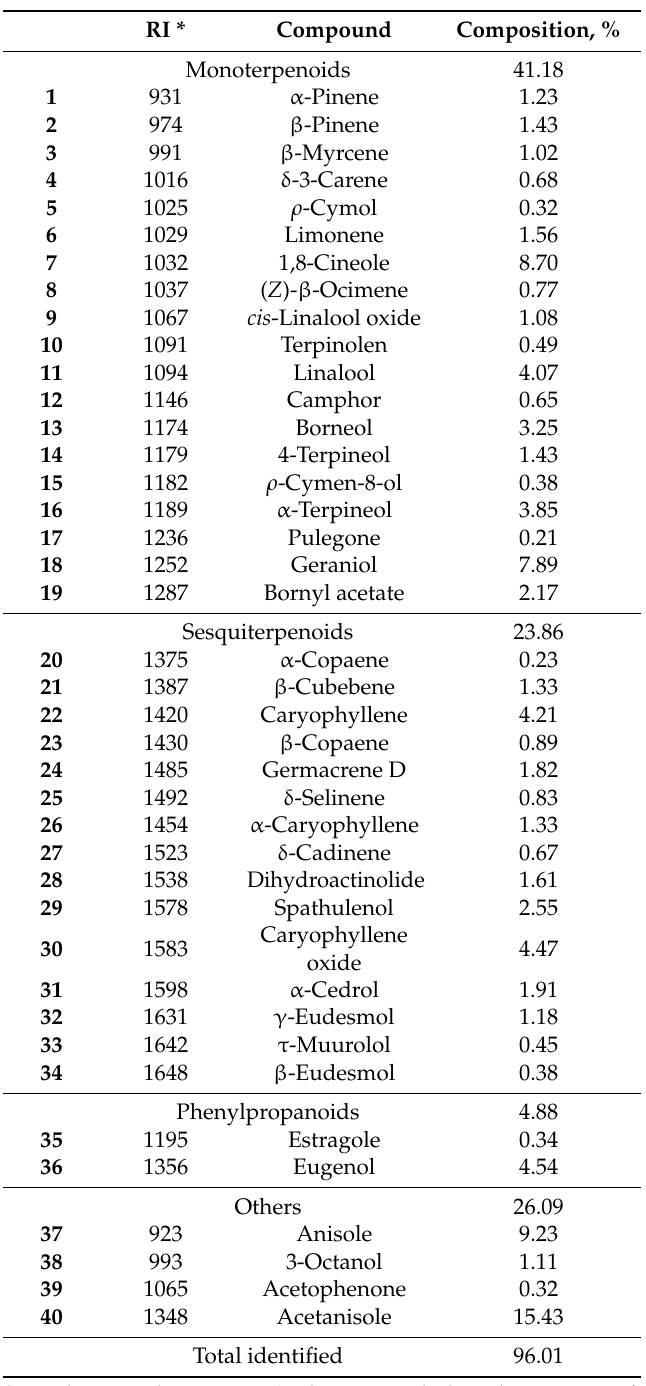
Table 1. Volatile compounds identified in the essential oil derived from Stachys riederi var. japonica aerial